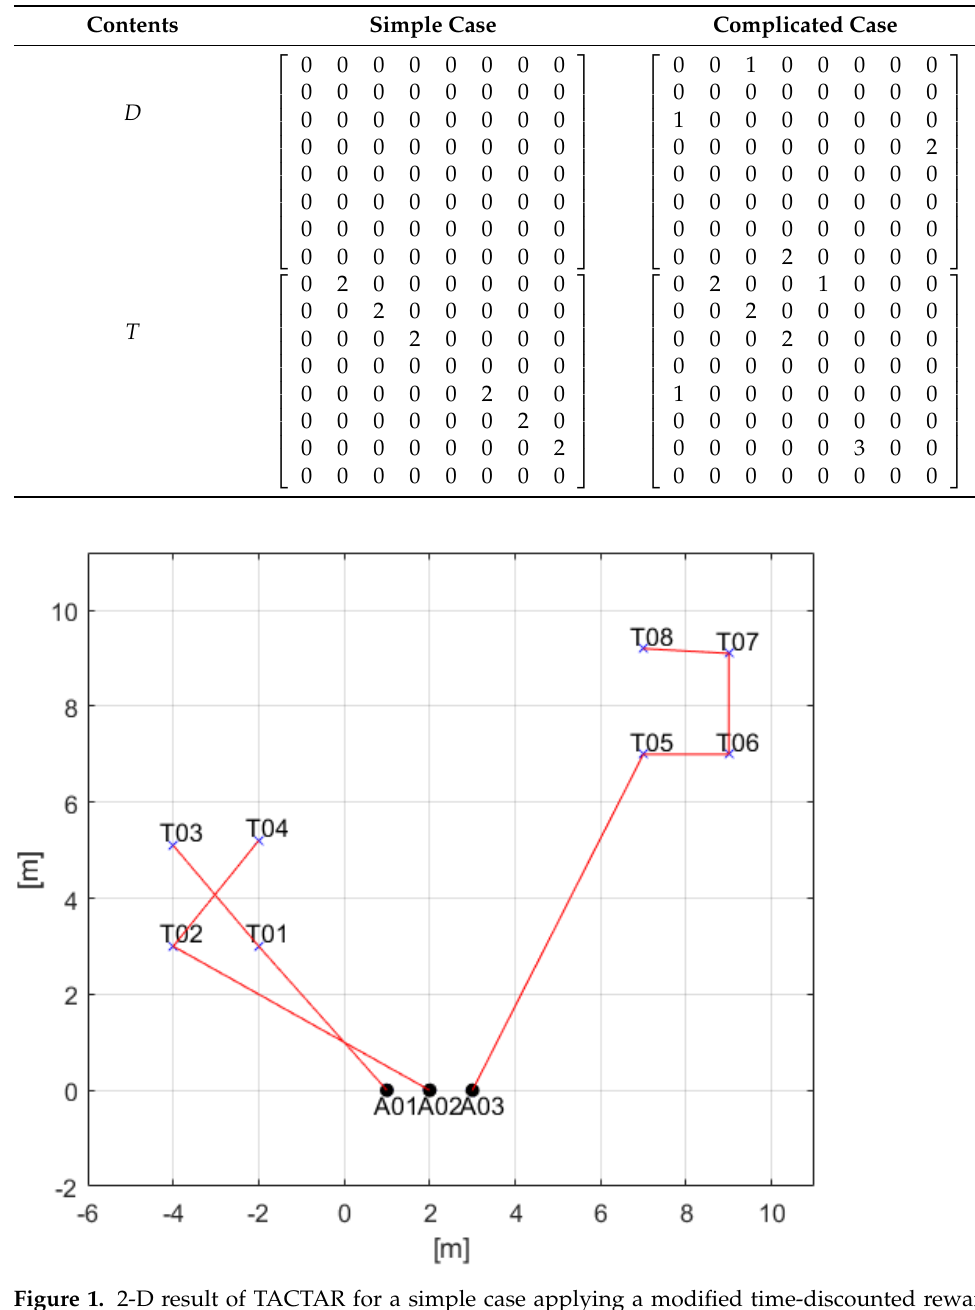
Figure 2. Computational time of TACTAR for a simple case applying a modified time-discounted reward scheme.